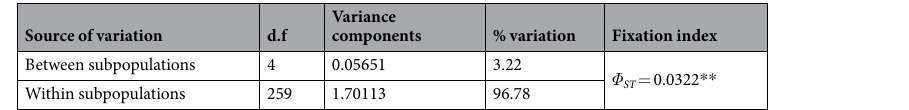
Table 3. Analysis of molecular variance (AMOVA). Significance of Φ ST : ** P <